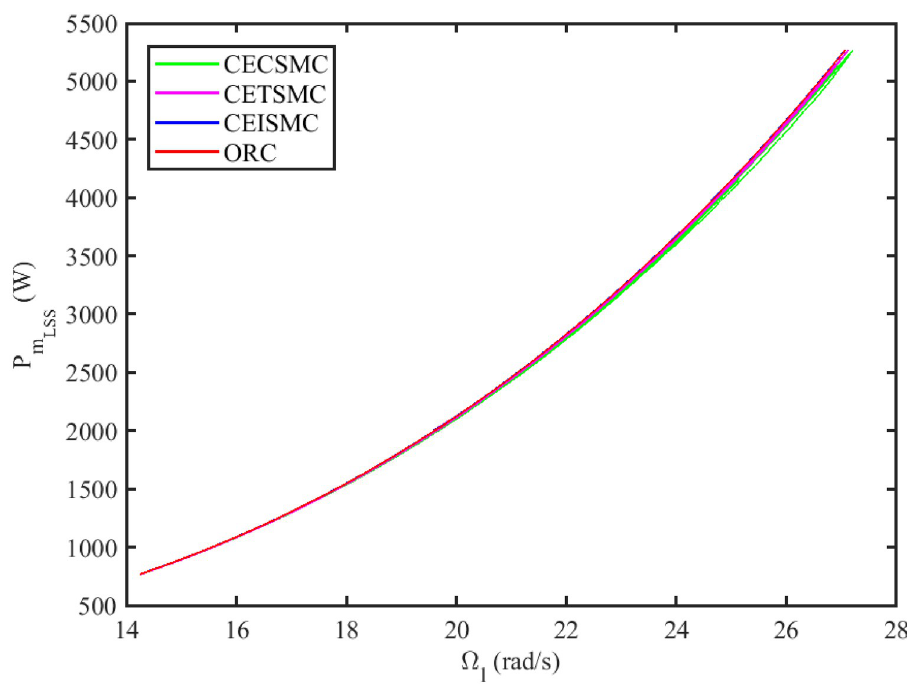
Fig 5. Low-speed shaft rotational speed versus low-speed shaft power.